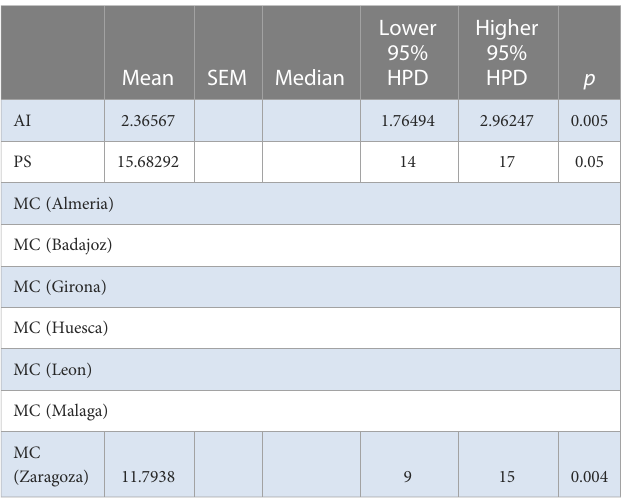
TABLE 10 BaTS algorithm analysis for the Spanish AMV population